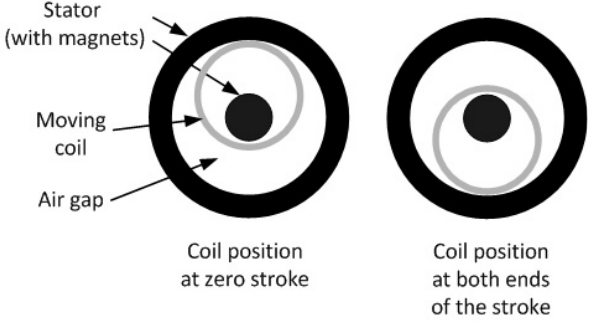
Figure 8. Principle of the eccentric coil mounting (transversal view; the actuation direction is orthogonal to the section).